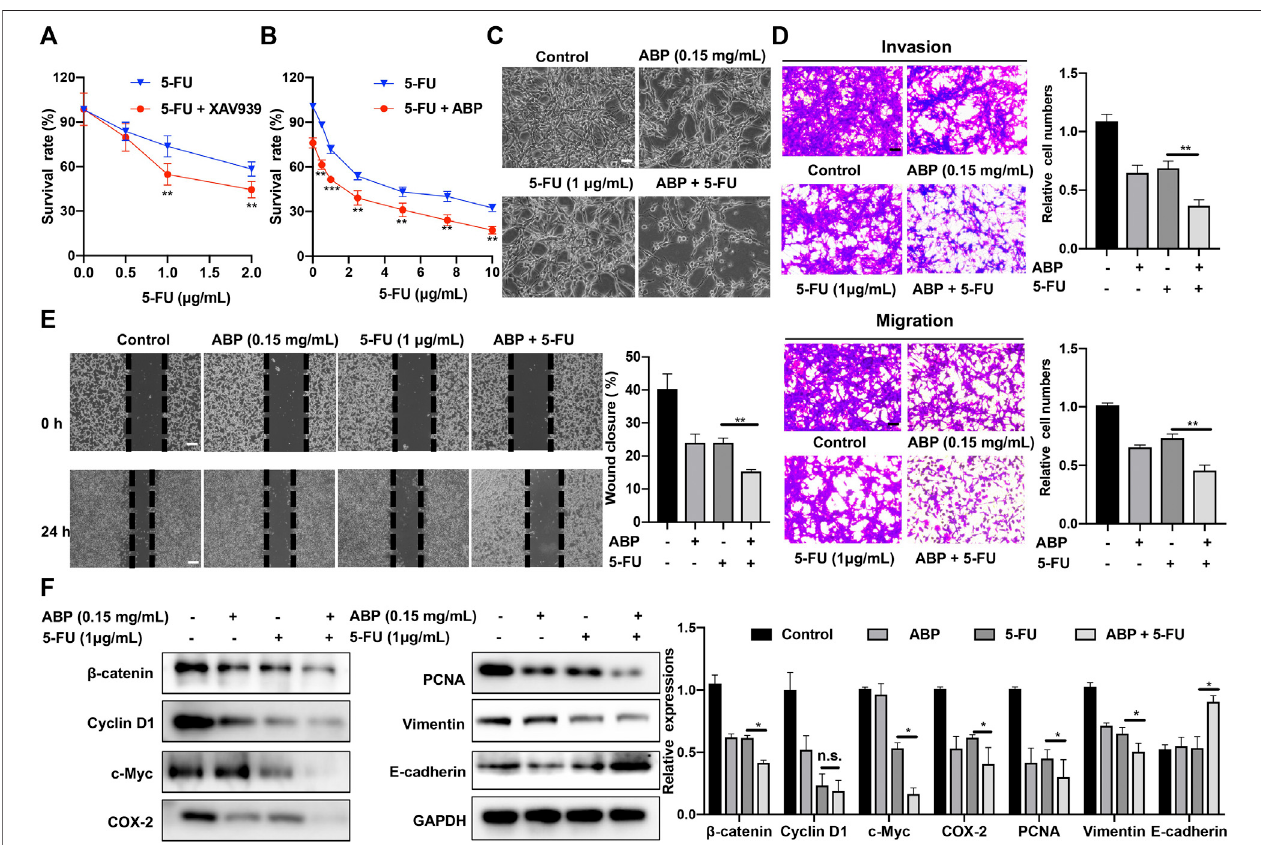
FIGURE4| ABPenhancestheanti-tumoref fi cacyof5-FUagainstCT26cells. (A-B) CCK-8assayexaminingtheeffectsofXAV939( β -catenininhibitor)andABPon the anti-tumor ef fi cacy of 5-FU against CT26 cells. (C) Cellular morphology of CT26 cells treated with ABP, 5-FU, and ABP + 5-FU for 24 h. Scale bar (cid:2) 50 μ m. (D) Transwell assays examining the enhancing effect of ABP on the anti-tumor ef fi cacy of 5-FU against CT26 cells. Scale bar (cid:2) 50 μ m. (E) Wound healing assay examining the enhancing effect of ABP on the anti-tumor ef fi cacy of 5-FU against CT26 cells. Scale bar (cid:2) 250 μ m. (F) Western blot examining the protein levels of β -catenin, CyclinD1,c-Myc,COX-2,PCNA,Vimentin,E-cadherin,anGAPDHinCT26cellstreatedwithABPand5-FU.Comparedwiththe5-FUgroup,* p < 0.05,** p < 0.01,n.s., no signi fi cance.